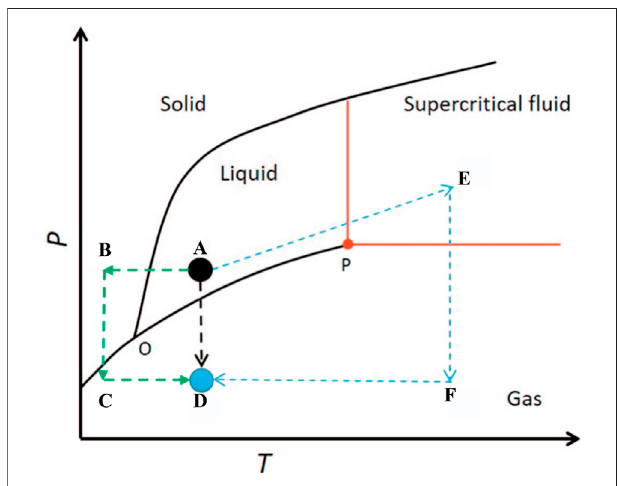
FIGURE 1 | Single-phase phase diagram (Kistler,